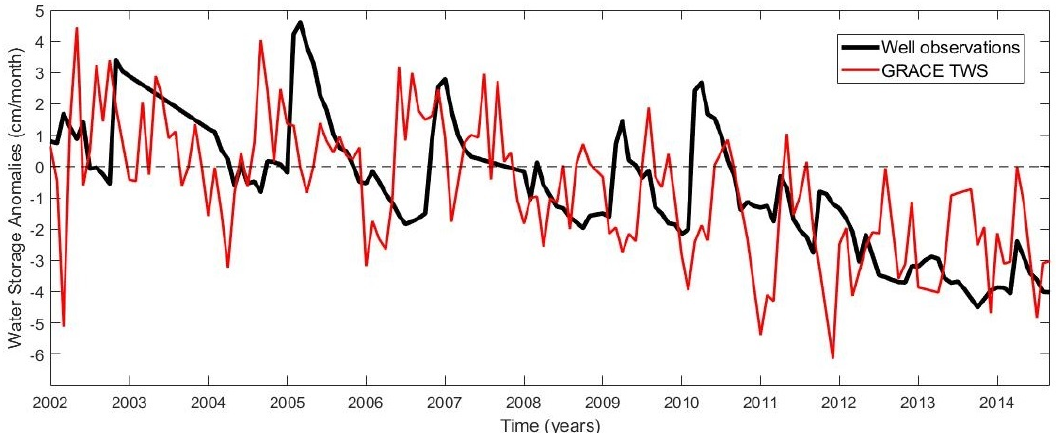
Figure 3. Time series of GRACE TWS and mean well observation anomalies over the UAE test site.